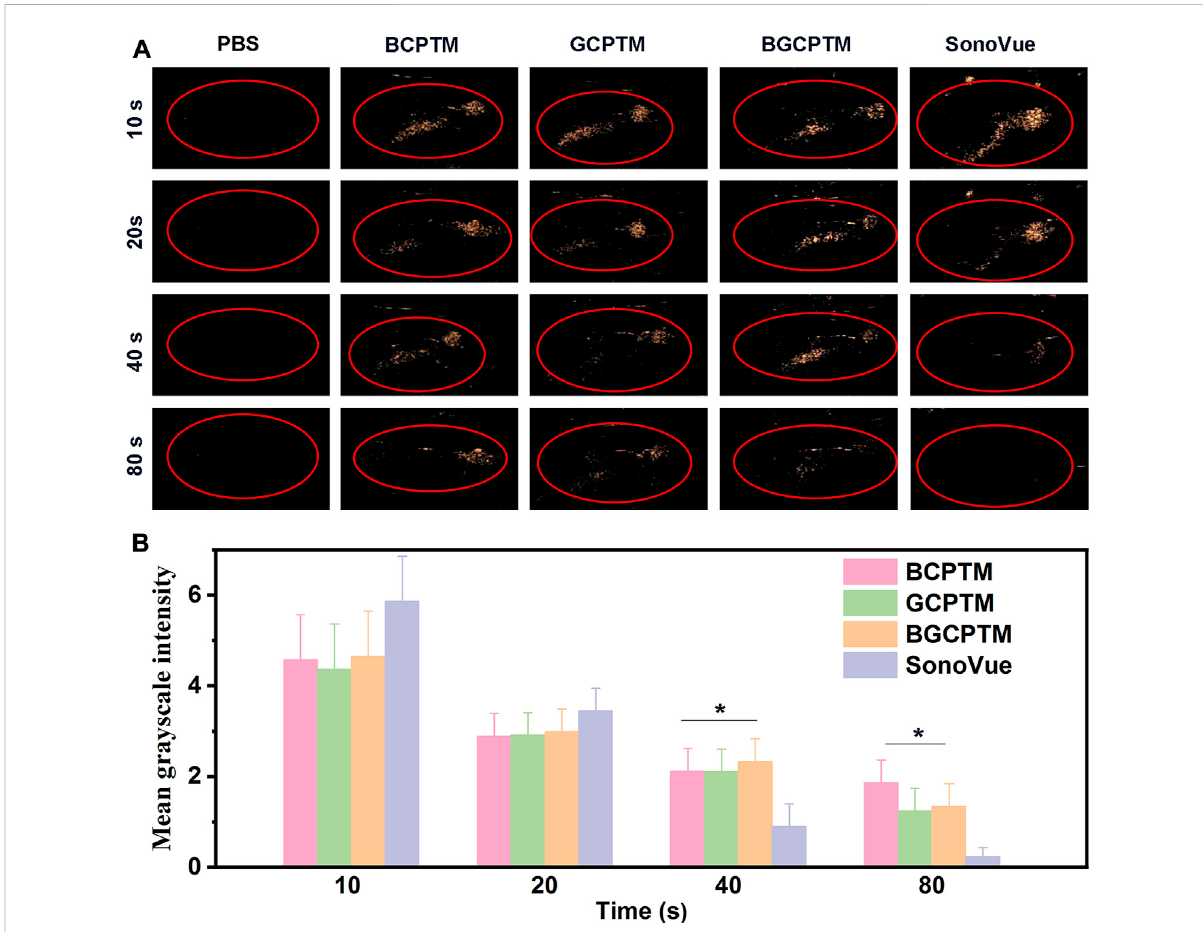
FIGURE 6 CEUS images of BCPTM, GCPTM, BGCPTM and SonoVue in rabbits liver ( n = 3). (A) Continuous CEUS images for 90 s in vivo . (B) MGI of the CEUS images.